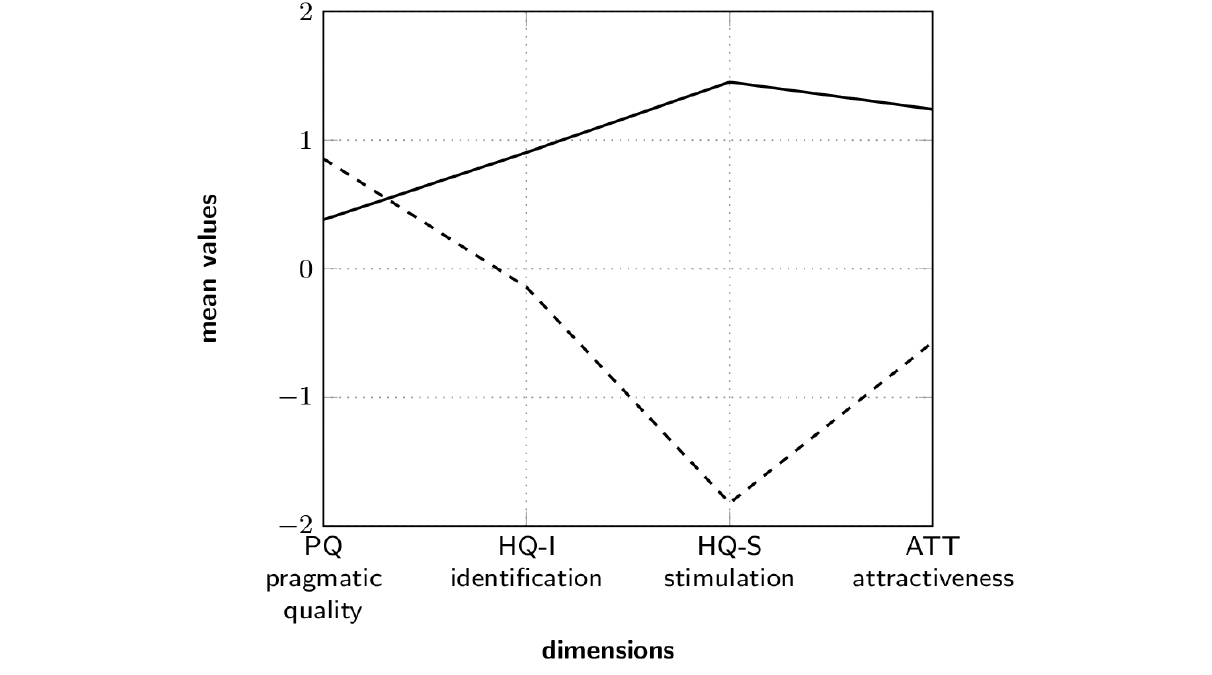
Figure 5. Average values for pragmatic quality (PQ), hedonic quality – identification (HQ-I), hedonic quality – stimulation (HQ-S), and attractiveness (ATT), based on evaluation of the AttrakDiff2 questionnaire (solid line: mARble group (6/10); dashed line: textbook group